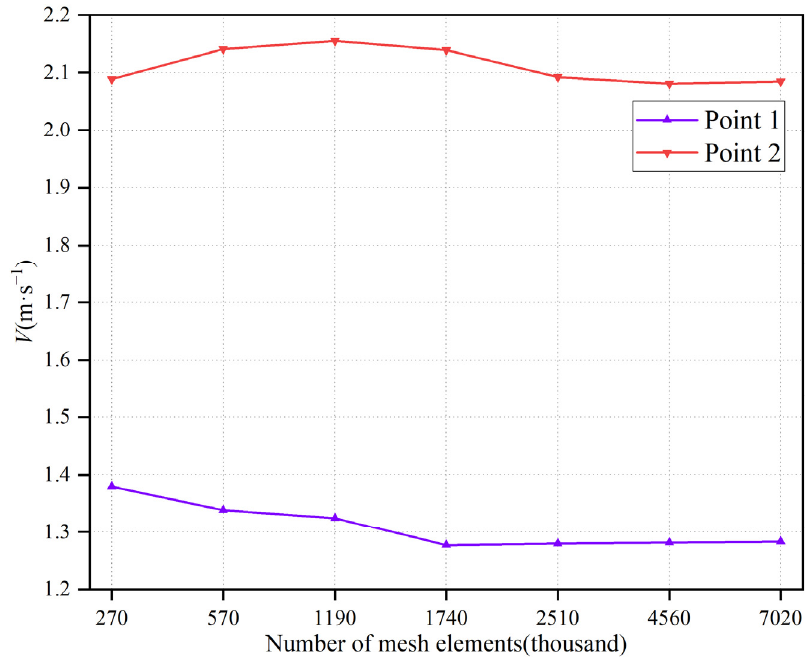
Figure 3. The results of the mesh independence study for the realizable k − ε model.